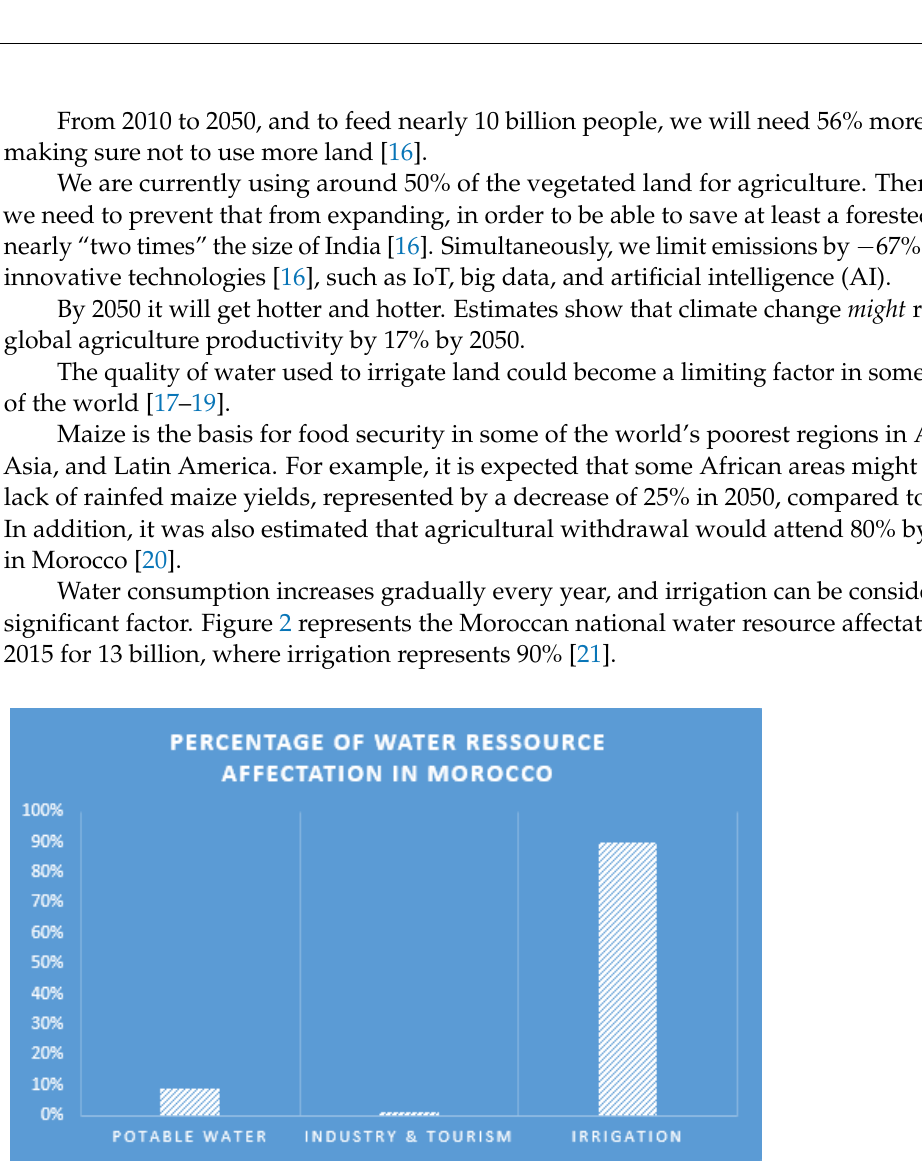
Figure 1. Major smart agriculture challenges.